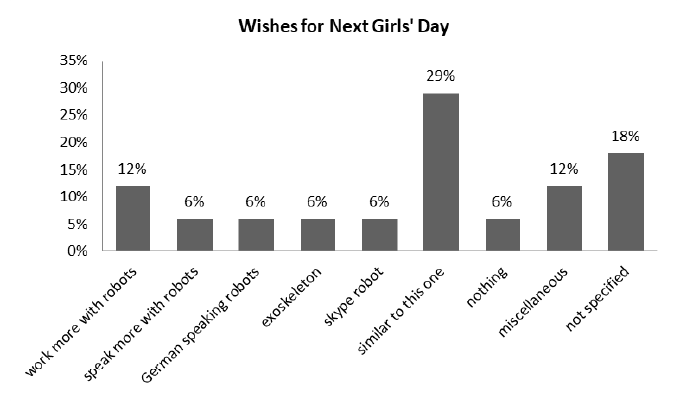
Fig. 4. Wishes for further